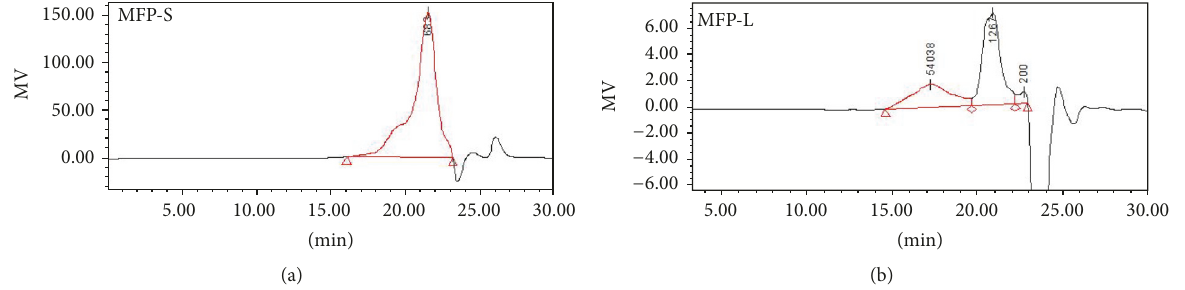
Figure 3: HPGFC profiles of MFP-S (a) and MFP-L (b) monitored with a refractive index